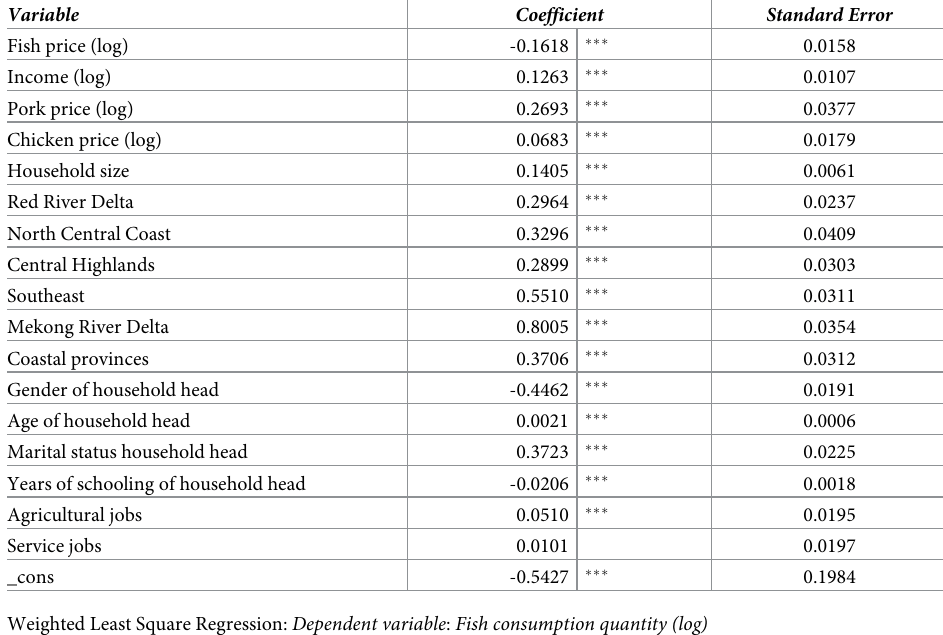
Table 4. Household’s fishery demand function in Vietnam,